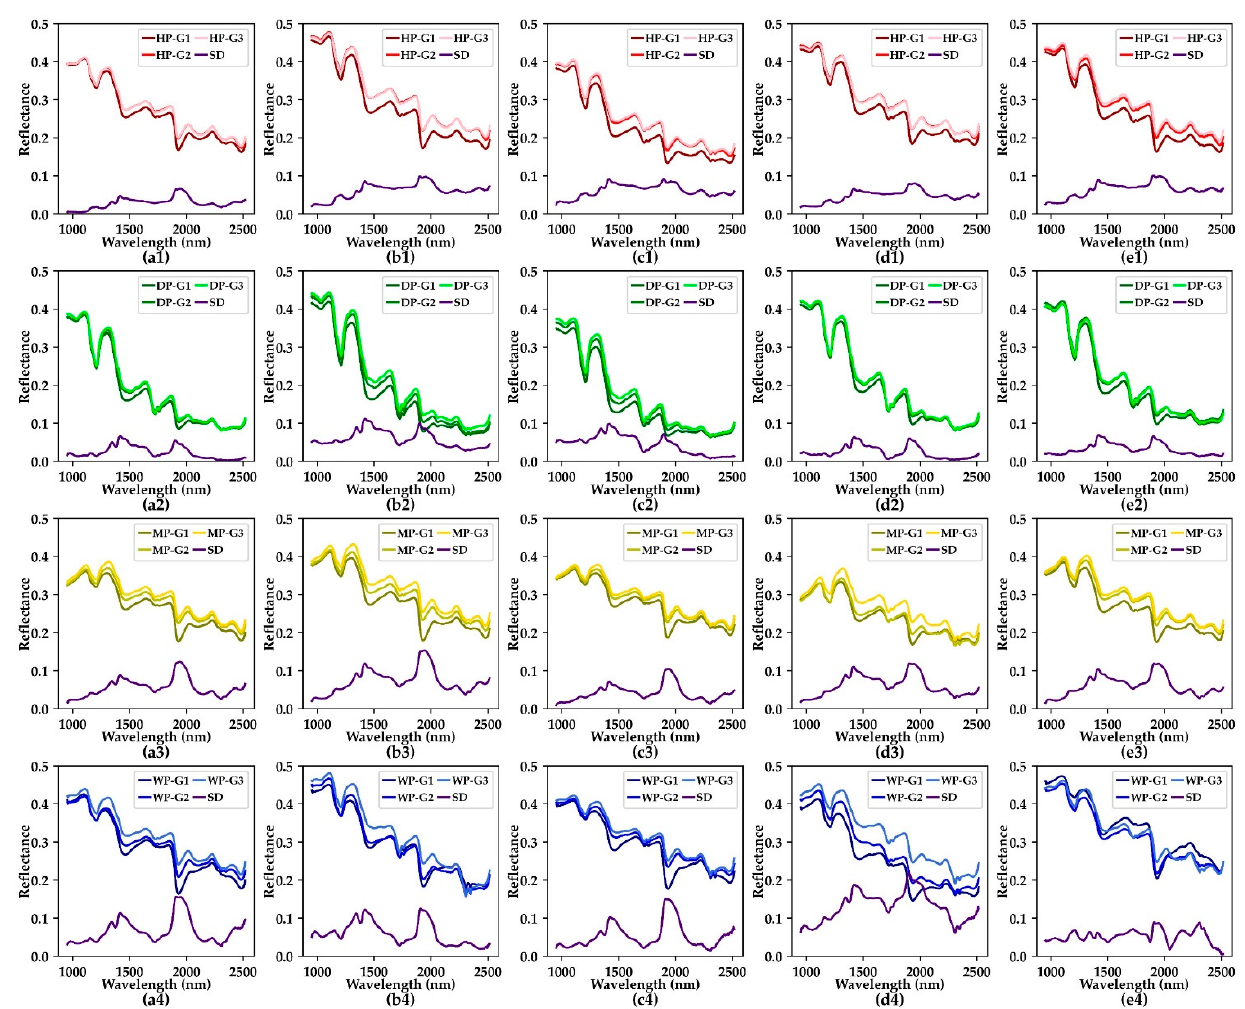
Figure 4. Average spectrum of each moisture content gradient for all varieties and classes. ( a1 – a4 ) BLACK, ( b1 – b4 ) DBS, ( c1 – c4 ) QC, ( d1 – d4 ) SLH, ( e1 – e4 ) XBS. HP, healthy peanuts; DP, damaged